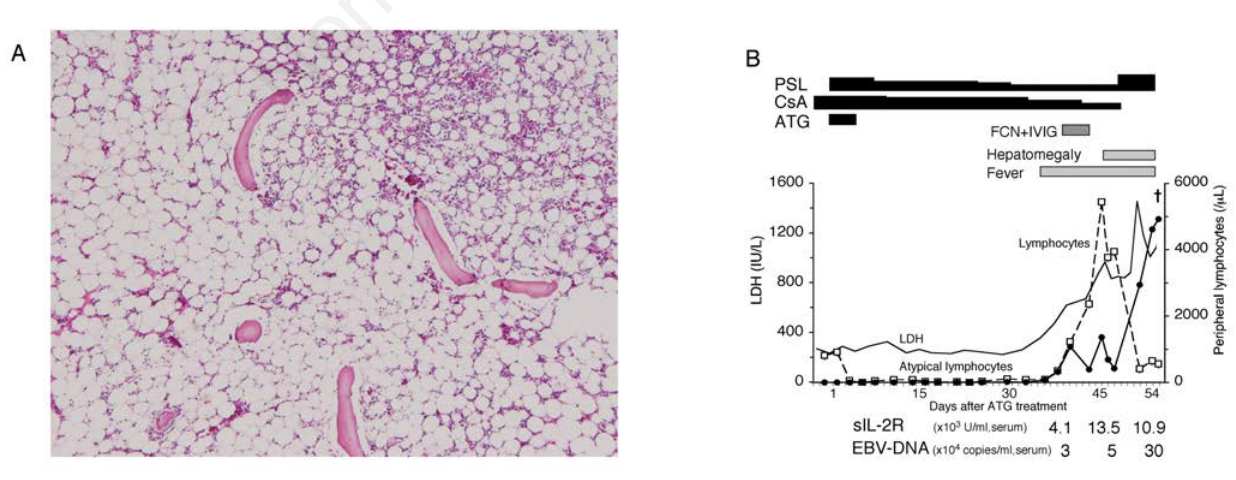
Figure 1. Severe aplastic anemia with aggressive LPD and EBV-reactivation. (A) Bone marrow biopsy showing markedly hypocellular marrow. (B) Immunosuppressive therapy, LPD, and EBV-proliferation. The T-cell population of lymphocytes disappeared after ATG therapy. PSL, prednisolone; CsA, ciclosporin; ATG, antithymocyte globulin; FCN, foscarnet; IVIG, intravenous injection of immunoglobulins; LDH, lactate dehydrogenase; sIL-2R, soluble IL-2